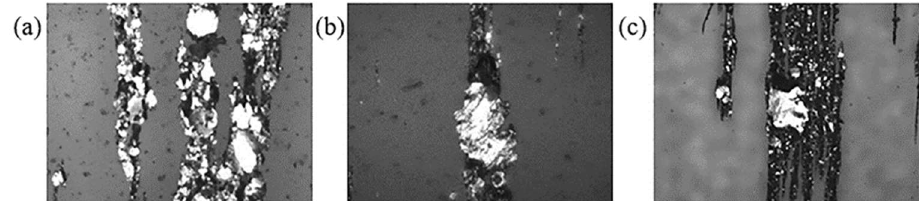
Figure 10. Amplification photograph of abnormal abrasive grains ( a ) abnormal abrasive chain, ( b ) sliding abrasive, ( c ) fatigue flake abrasives.